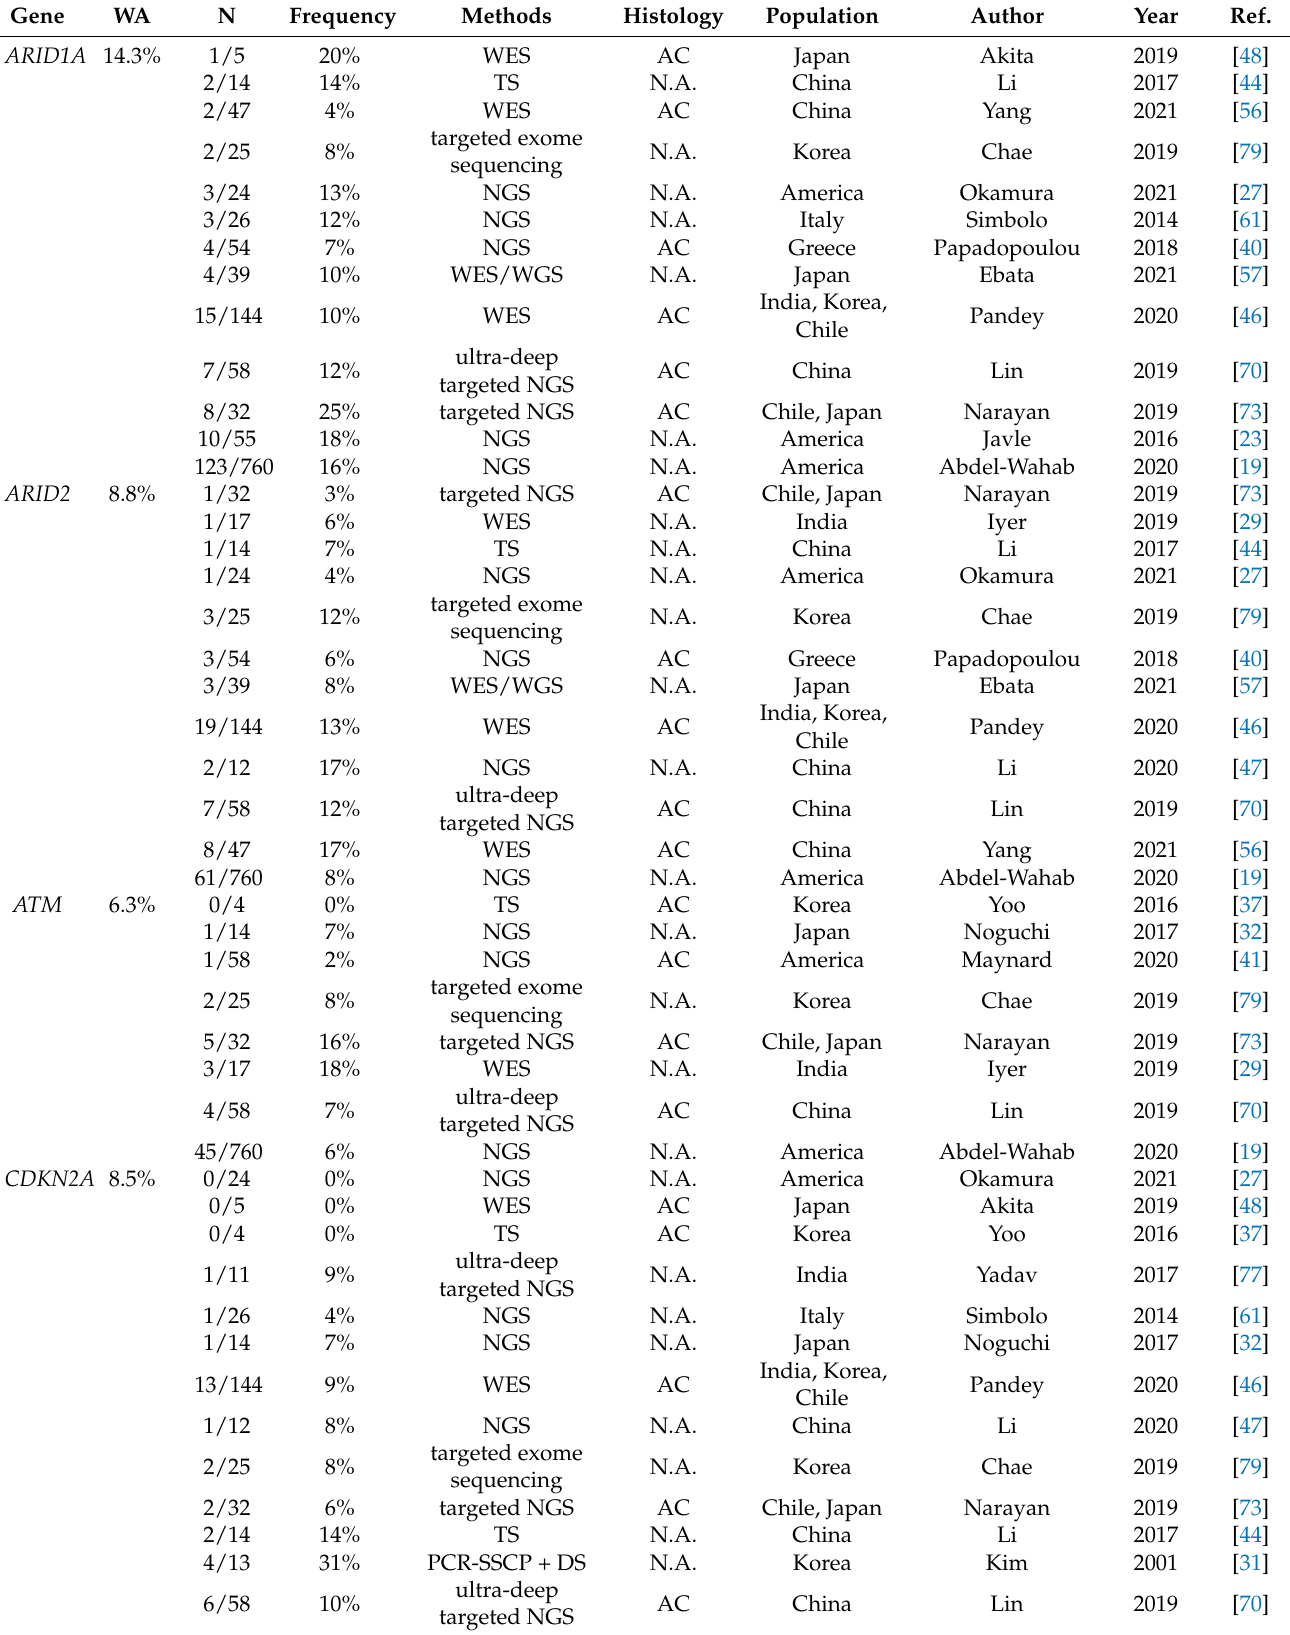
Table A2. Studies analyzing frequently mutated genes in gallbladder cancer. Gene WA N Frequency ARID1A 14.3%